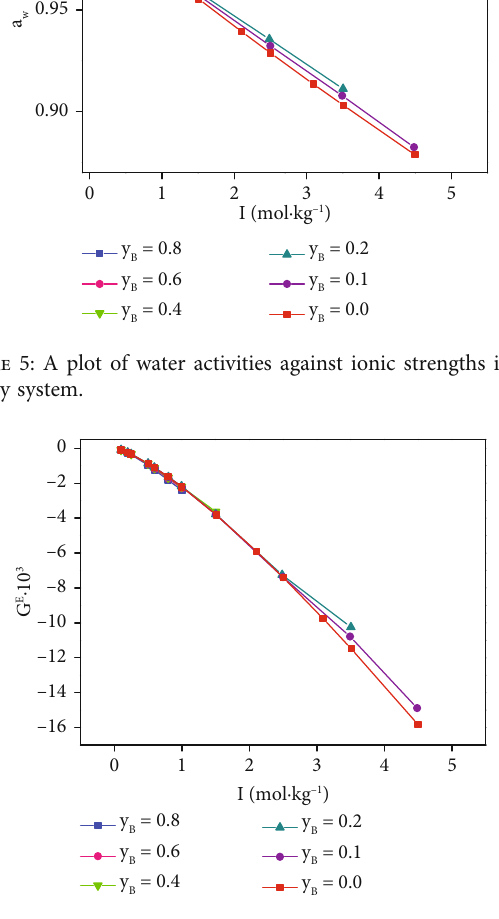
Figure 6: A plot of excess Gibbs energies against ionic strengths in the ternary